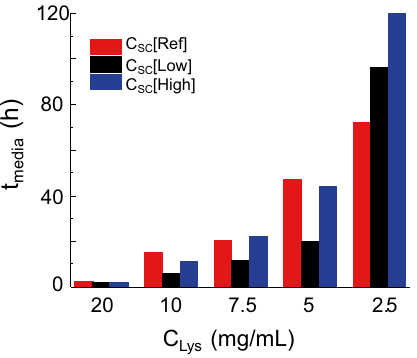
Figure 4. Median induction time extrapolated from Fig. 2 in the droplets with the C Lys of 2.5–20 mg/mL and three different concentrations of the biotemplates.